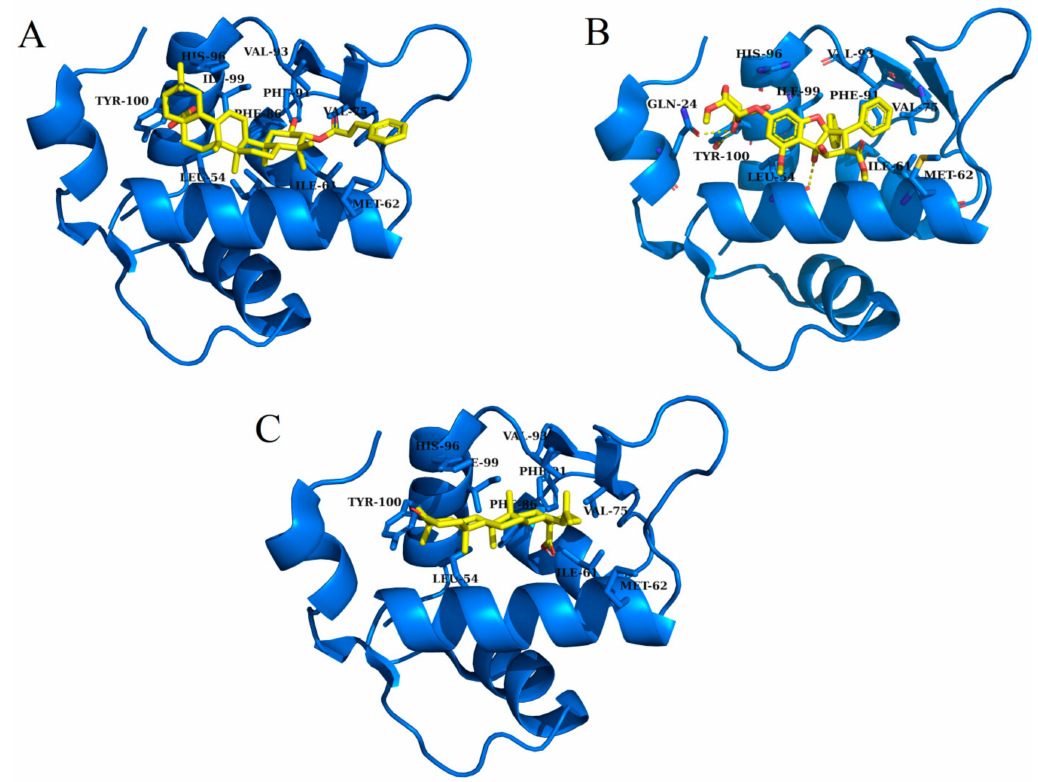
Figure 2. Illustration of terpenes binding inside MDM2 active site. ( A ) 3- trans - p -coumaroyl maslinic acid, ( B ) Silvestrol and ( C ) Betulonic